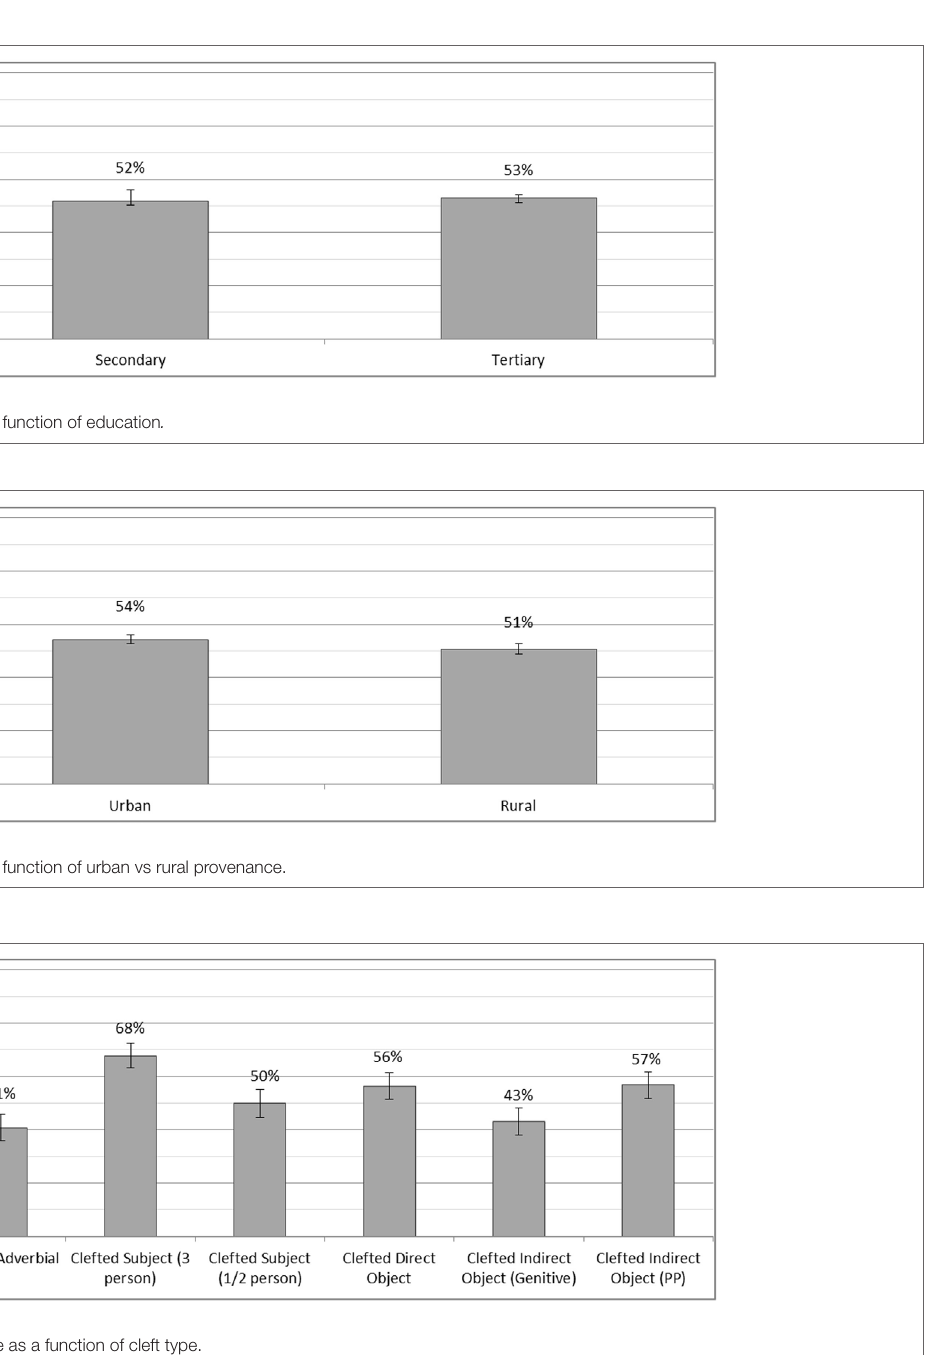
FigUre 5 | Percentage of cleft acceptance as a function of cleft